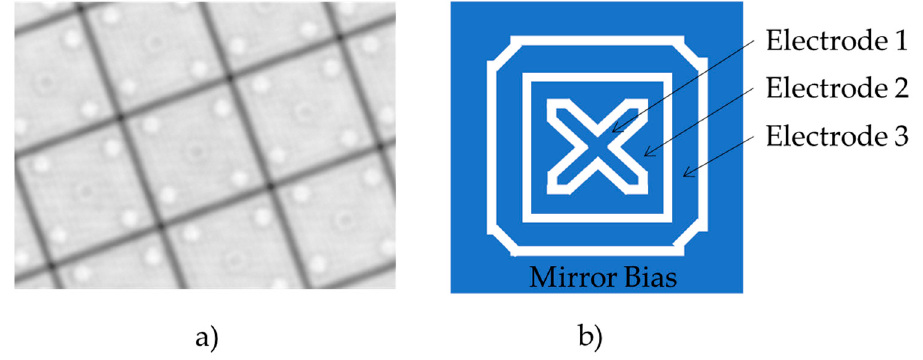
Figure 1. ( a ) White light microscope image of PLM mirror array. ( b ) Schematics of 3-bit PLM micromirror electrostatics electrode arrangement. The three electrodes are placed underneath pixels with 10.8 um pitch.